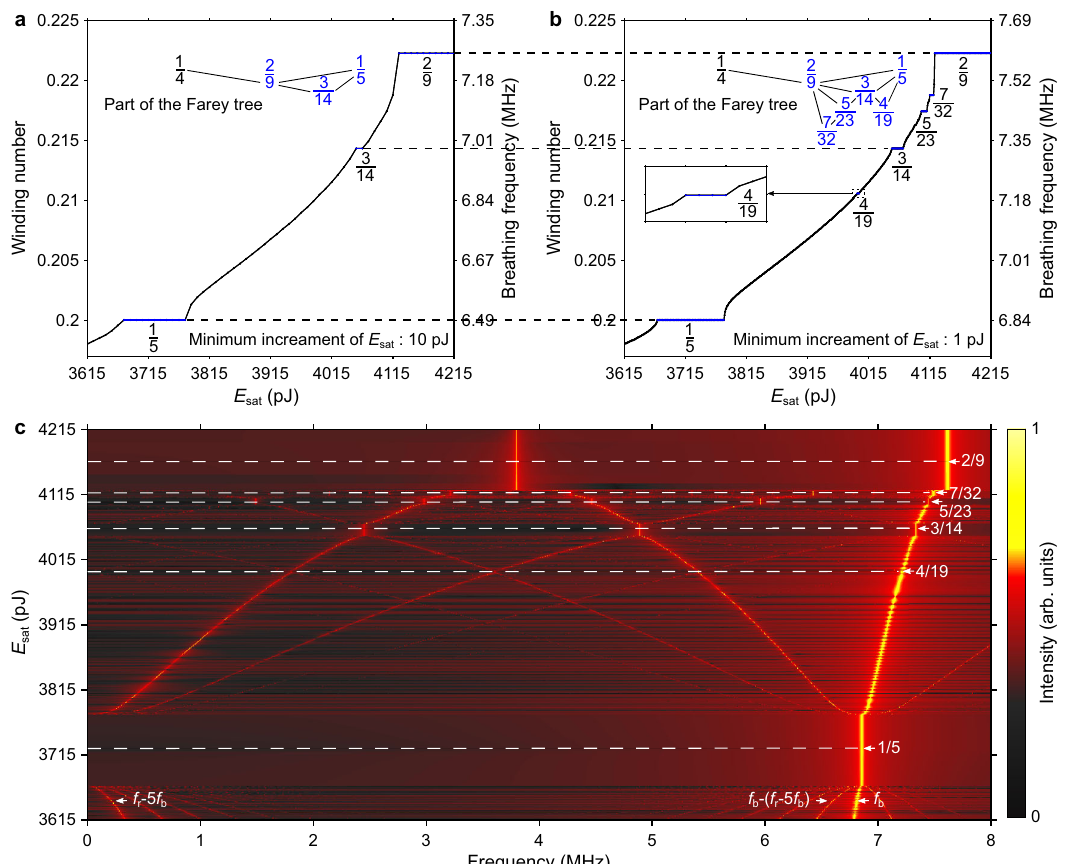
Fig. 6 | Farey tree and devil ’ s staircase observed in the numerical simulations. a , b Breathing frequency (winding number) as a function of the gain saturation energy E sat (related to the pump power in the experiment) varied with a step of 10 and 1pJ, respectively. With the smaller step, more plateaux are observed, eviden- cing a fractalpattern. Inthe insets areshown the parts of the Farey tree containing